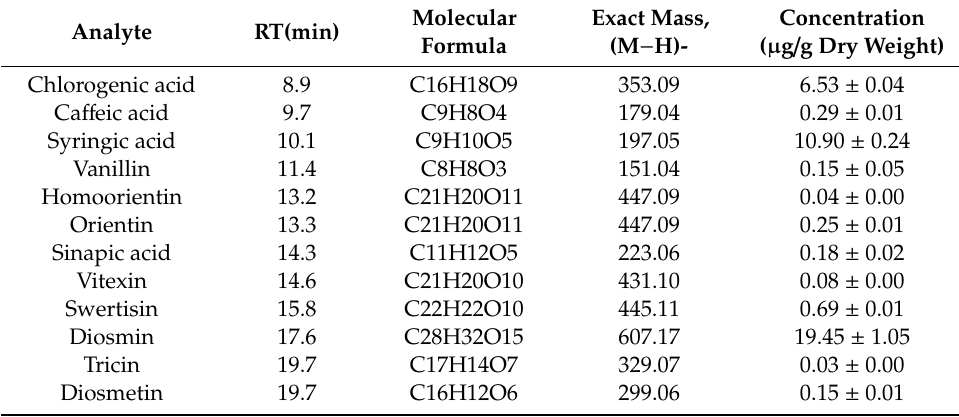
Table 2. Polyphenol composition of Officinol™ by LCMS analysis *.